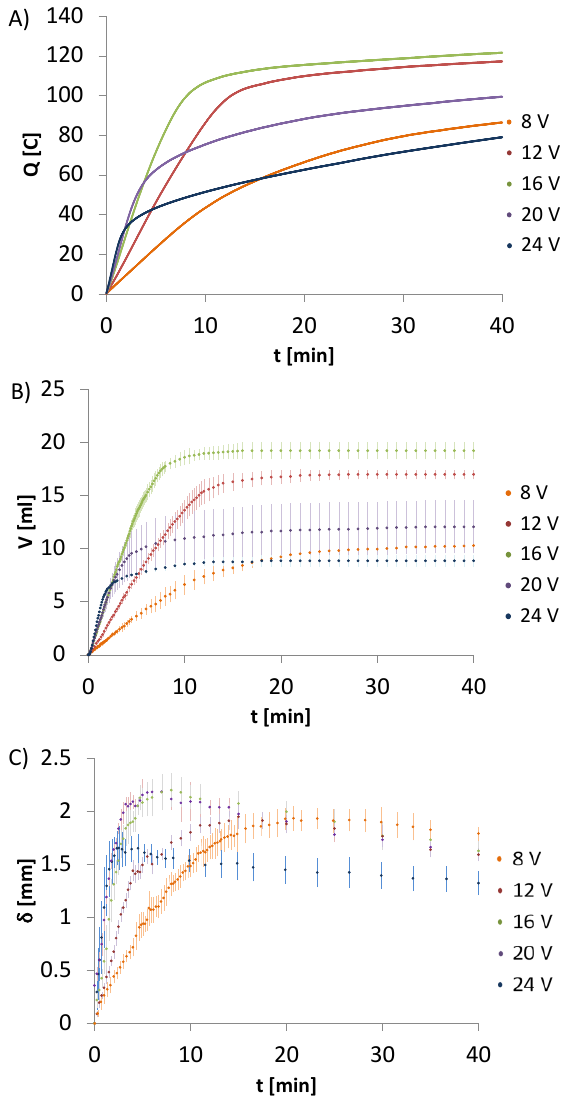
Figure 3. Change of ( A ) charge, ( B ) hydrogen volume, and ( C ) deposit thickness over time for electrodeposition from chitosan-hydroxyapatite colloidal solution initiated at different voltages. Data are shown as a mean ± standard deviation (n = 3). Table 2. Quantitative characteristics of electrodeposition from chitosan, hydroxyapatite, and chitosan-hydroxyapatite colloidal solutions. Data are shown as mean values (n = 3). Q t —total electric charge, 𝑛 𝐻 —amount of produced hydrogen, 2 X—water content, 𝜌 a —apparent density.